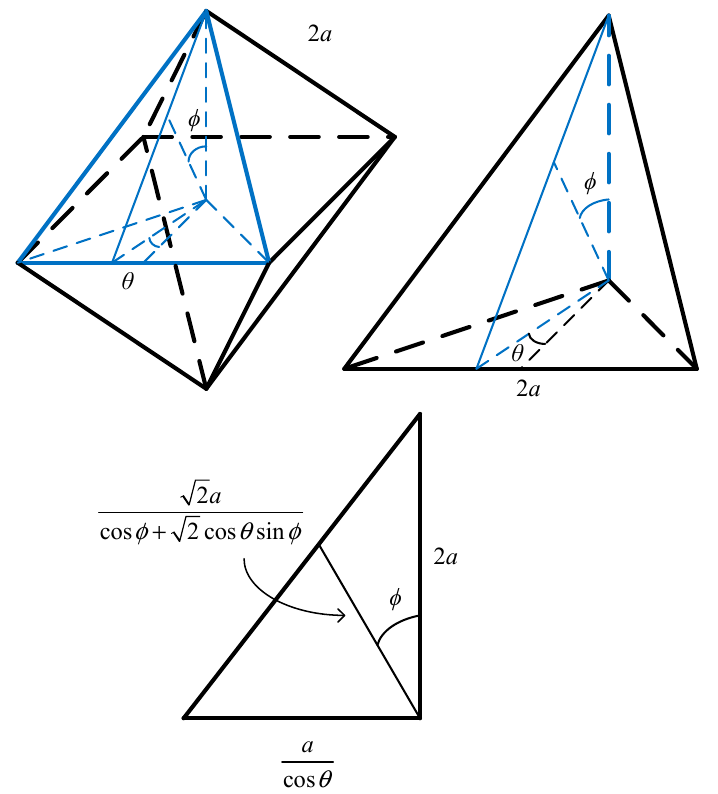
Figure 8. An illustration of a regular octahedron and the calculation of its shape entropy. It is not difficult to see that the shape entropy of 3D continuous cases, defined in Section 3.1, is independent of the size of the geometry, a , and is only related to the shape. case log(2 π ) + 1 = 2.83788... Table 3. The shape entropies of regular polyhedrons. Number of Faces of Regular Polyhedrons